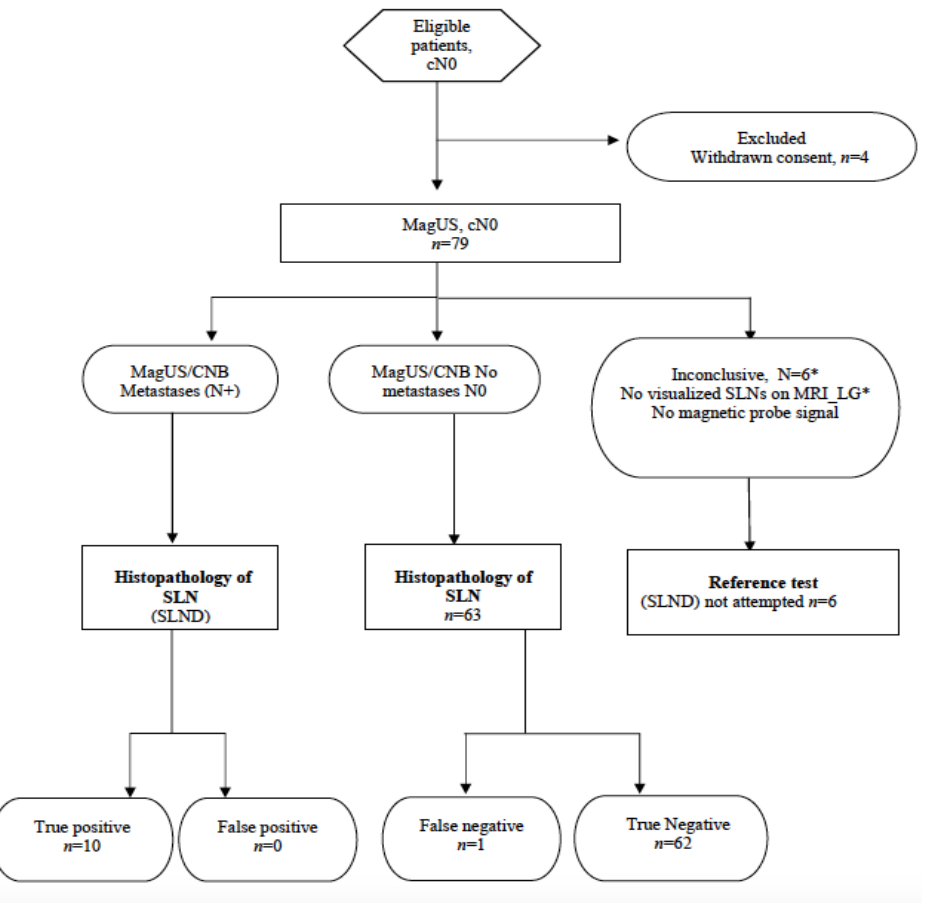
Figure 5. STARD flow diagram. * MRI_LG: Magnetic resonance imaging Lymphography. SLND: Sentinel Lymph Node Dissection. Table 1. Patient characteristics.